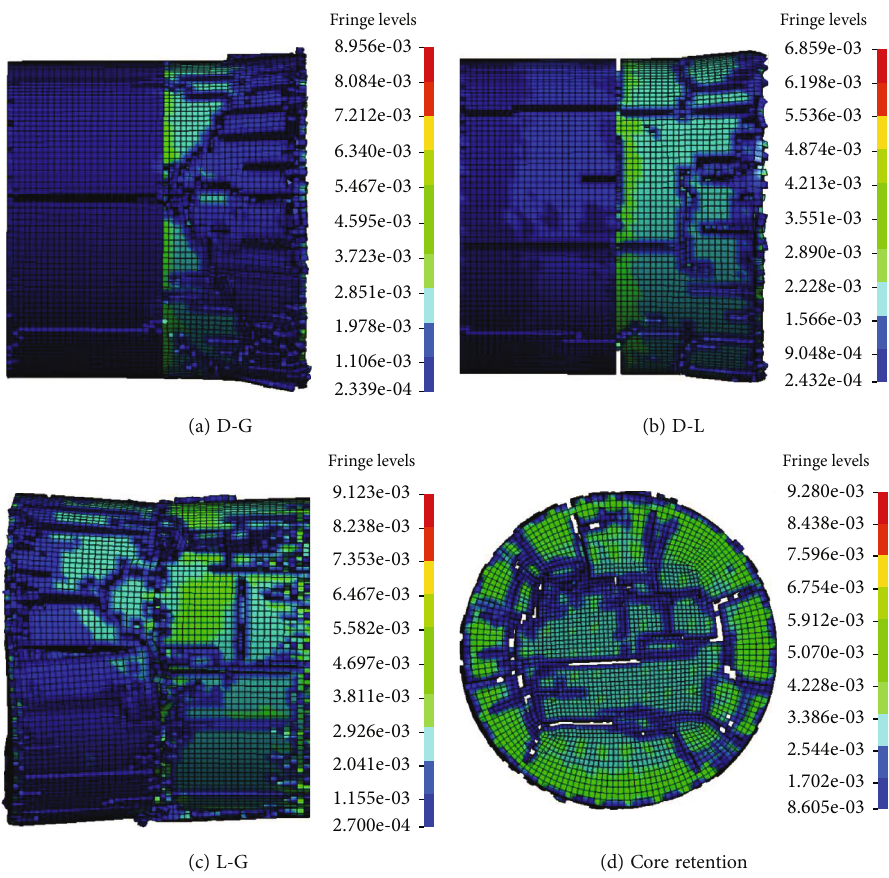
Figure 10: The fi nal failure states of the layered rock